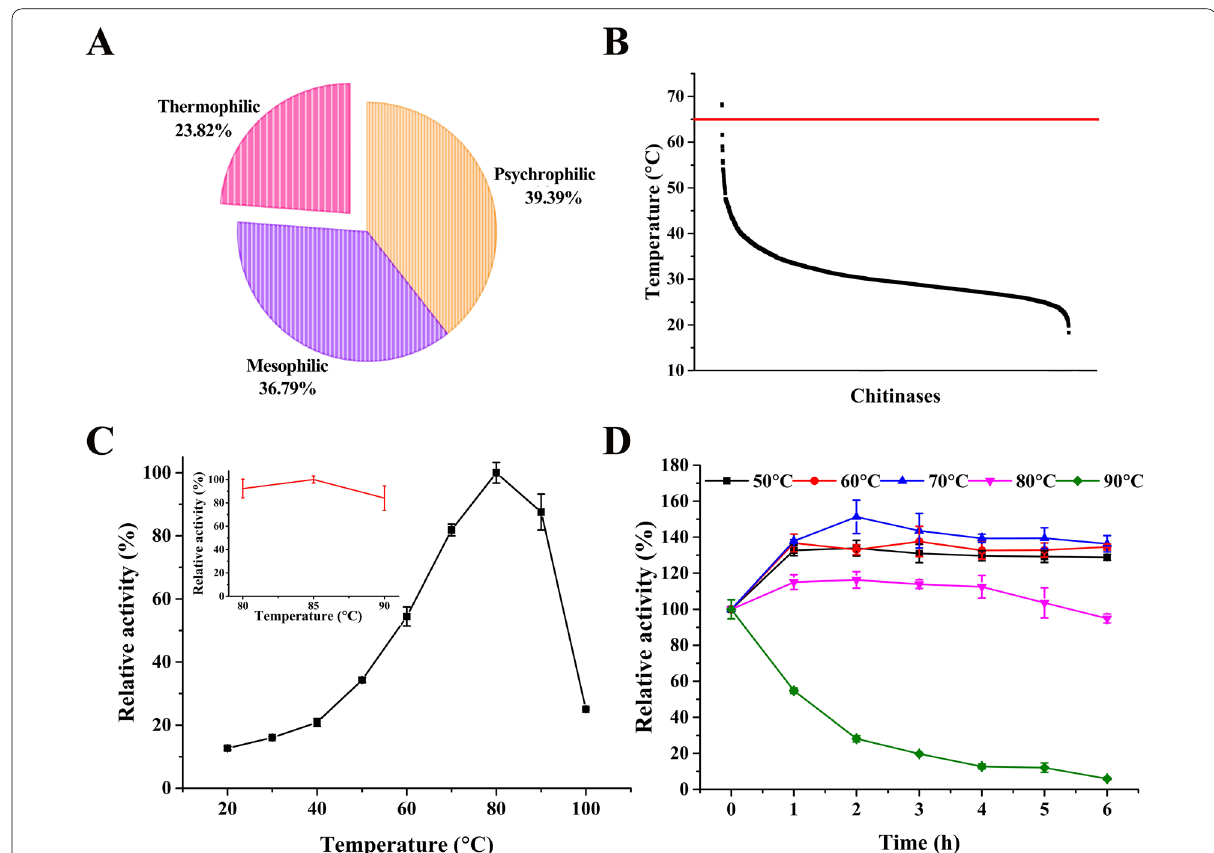
Fig. 2 Biochemical characteristics of Chi304. A The number of predicted psychrophilic, mesophilic, and thermophilic proteins among the total chitinases screened from the ocean metagenome. B Predicted optimal temperatures of screened chitinases. C Optimum temperature and D thermal stability of selected chitinase